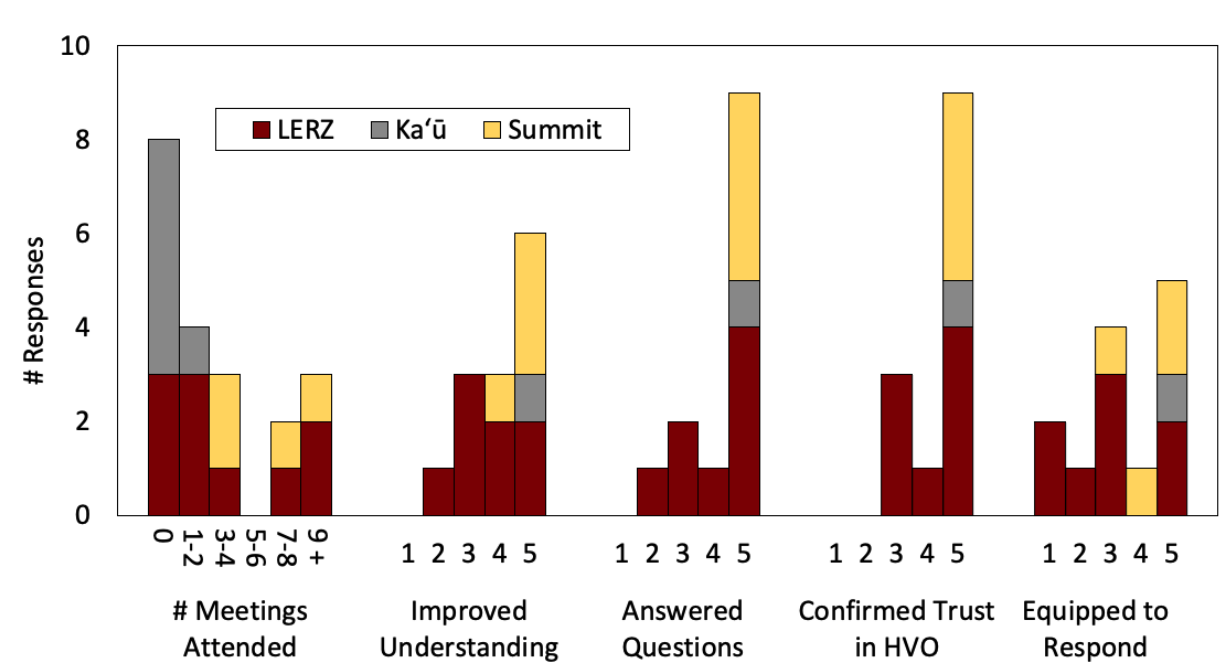
Figure 2: Responses from participants regarding in-person community meetings attended by the U.S. Geological Survey Hawaiian Volcano Observatory (HVO). The first cluster of bar graphs tallies how frequently participants reported attending community meetings, while the remaining four clusters plot participants’ Likert-type scores in response to the following questions: “To what extent did you feel that attending community-wide meetings during the eruption ... (a) improved your understanding of volcano hazards?; (b) answered your questions about the eruption and [summit caldera] collapse?; (c) confirmed your trust in HVO?; and (d) helped you feel better equipped to respond to the eruption?” Our Likert-type scale corresponds with the following qualitative descriptions: 1: "not at all," 2: “not much,” 3: “fair,” 4: “great,” 5: "very